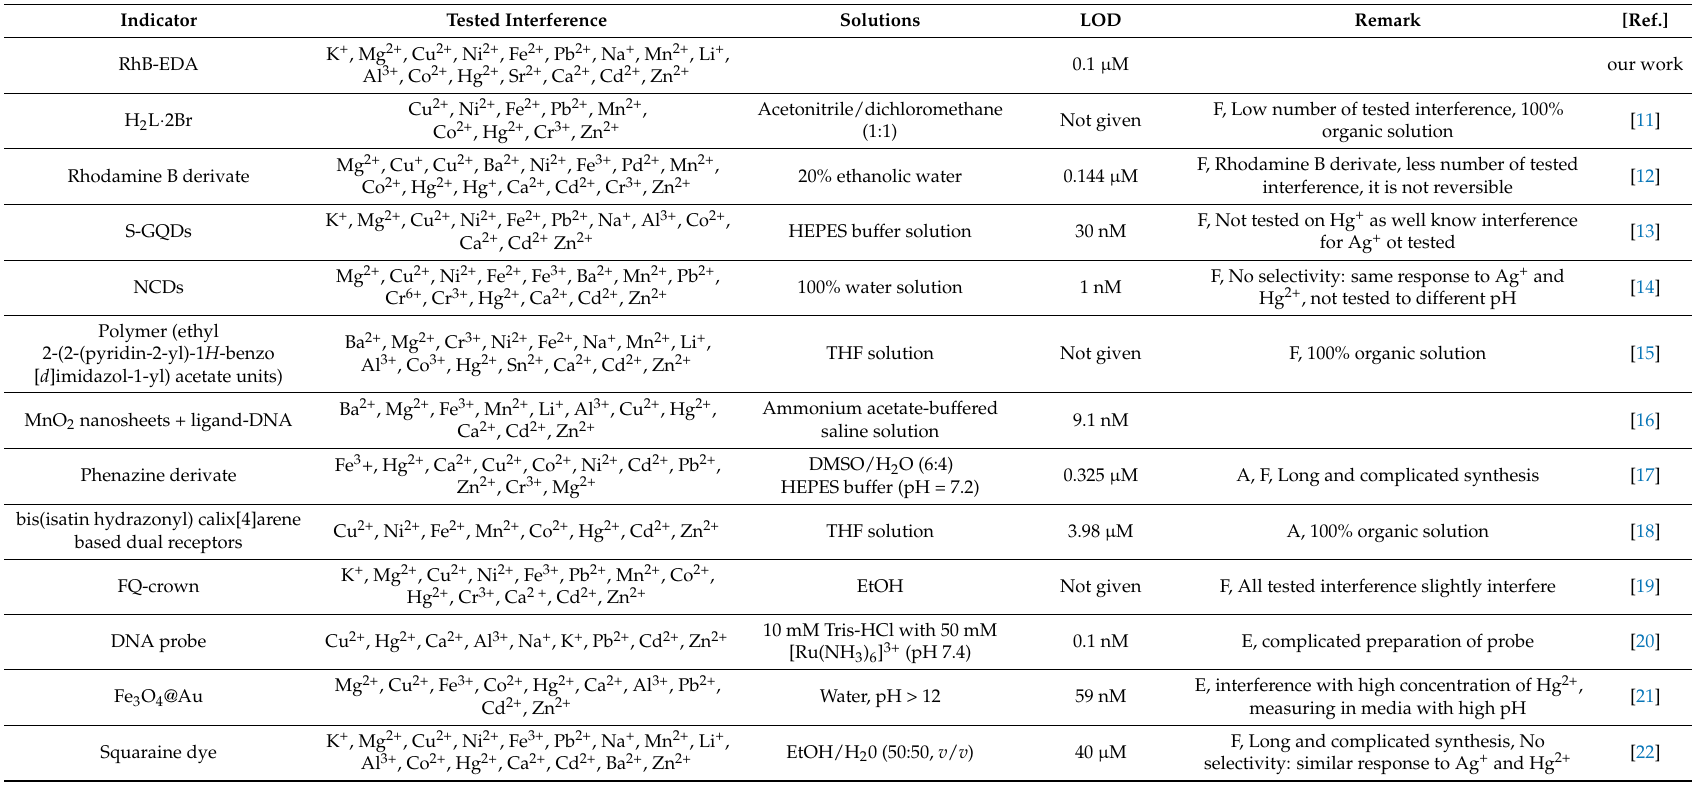
Table 2. Comparison data of developed probe-based sensors intended for on-site detection of Ag